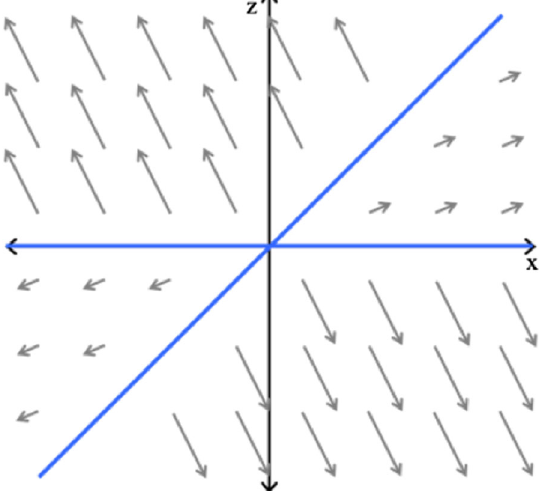
FIG. 3. Possible solution for the primary interview task. The cross sections of the charged sheets are represented by thick blue lines. The electric field is represented by gray arrows. The electric field is uniform in each of the four regions established by the